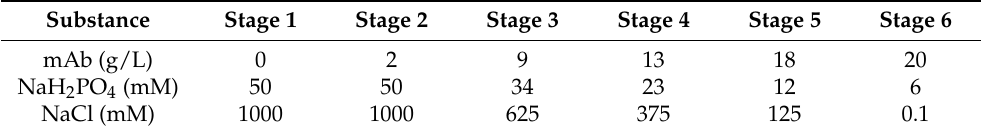
Table 2. Prepared mAb samples with expected salt concentrations for theoretical ultrafiltration/diafiltration (UF/DF)